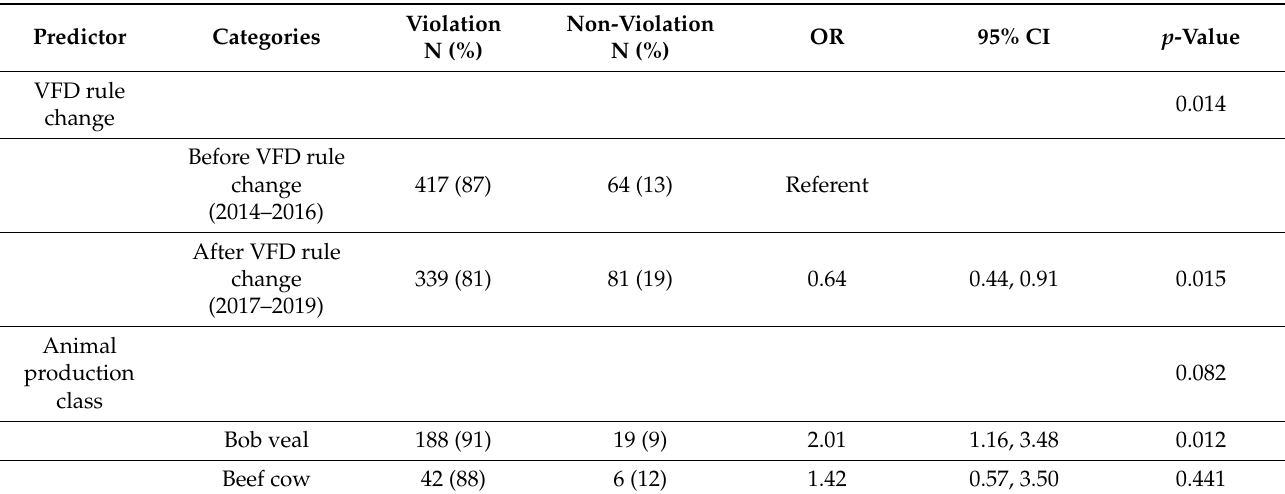
Table 3. Univariable association between predictors and detection of violative residues of sulfon- amides in the tissue of food animals ( n = 901) from the IGS,